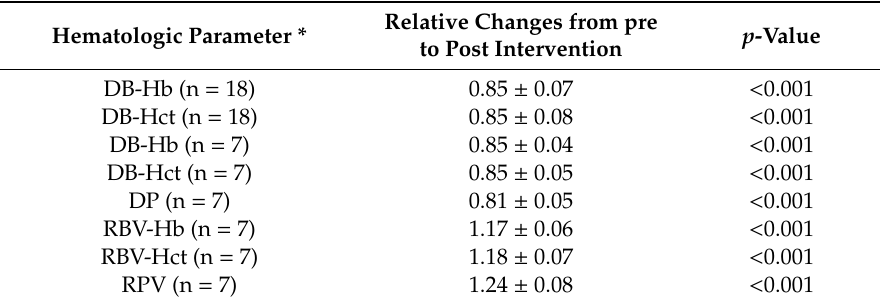
Table 3. Maternal hemodilution following